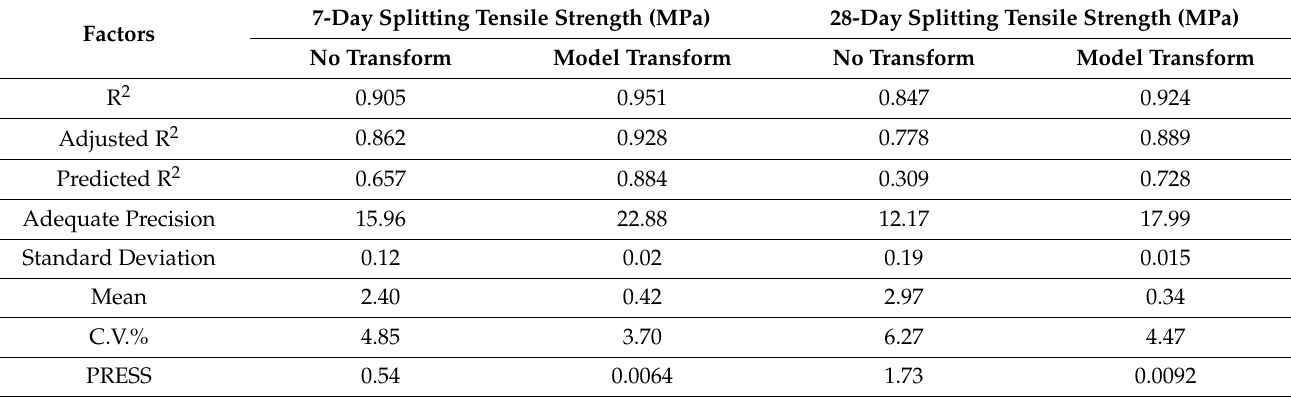
PRESS = Predicted Residual Error Sum of Squares, C.V. = Coefficient of